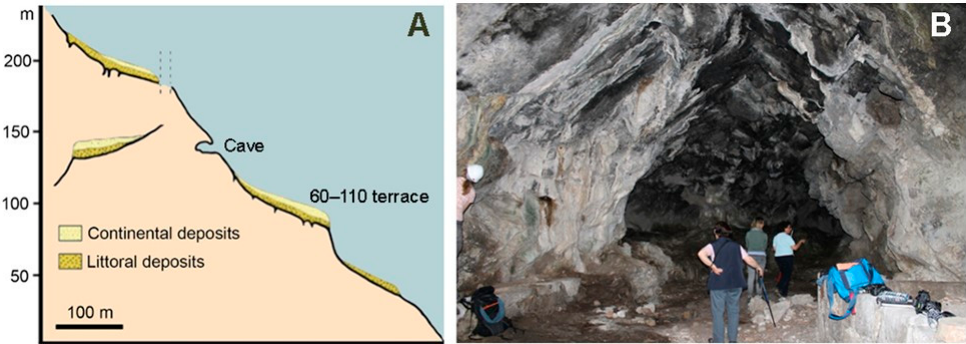
Figure 14. ( A ) Ideal section showing the location of the Taormina Cave in relation to the terraces in Geosciences 2022 , 12 , x FOR PEER REVIEW the area [60]. ( B ) The Taormina Cave seen from the entrance.